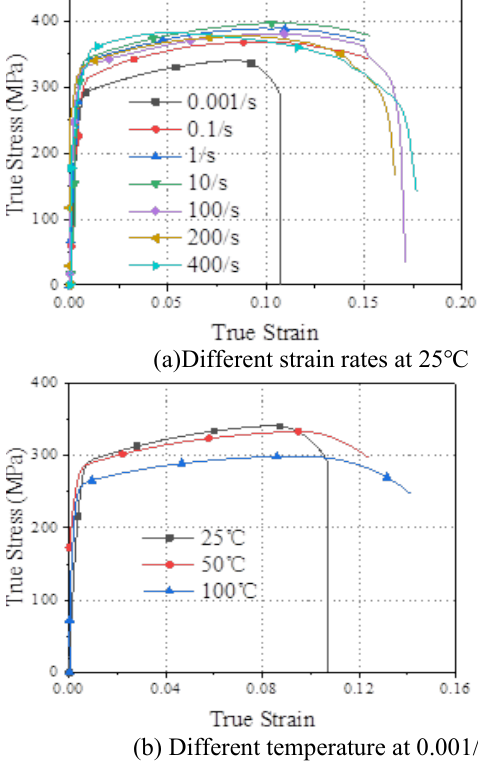
Table 2. Three material